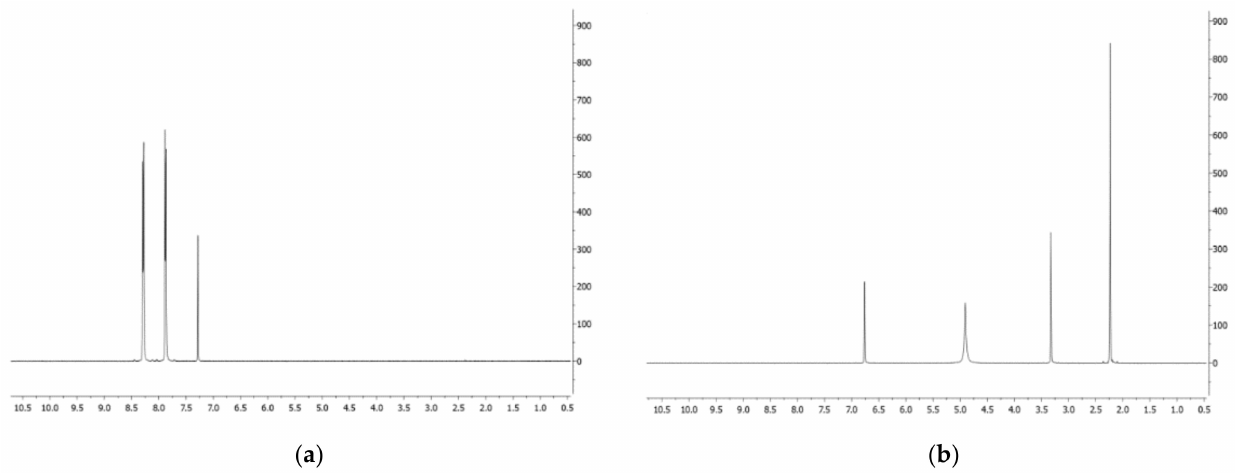
Figure 3. ( a ) 1 H-NMR spectrum of phenazine ( 1 ) recorded in CDCl 3 at 400 MHz; ( b ) 1 H-NMR spectrum of mesaconic acid ( 2 ) recorded in CD 3 OD at 400